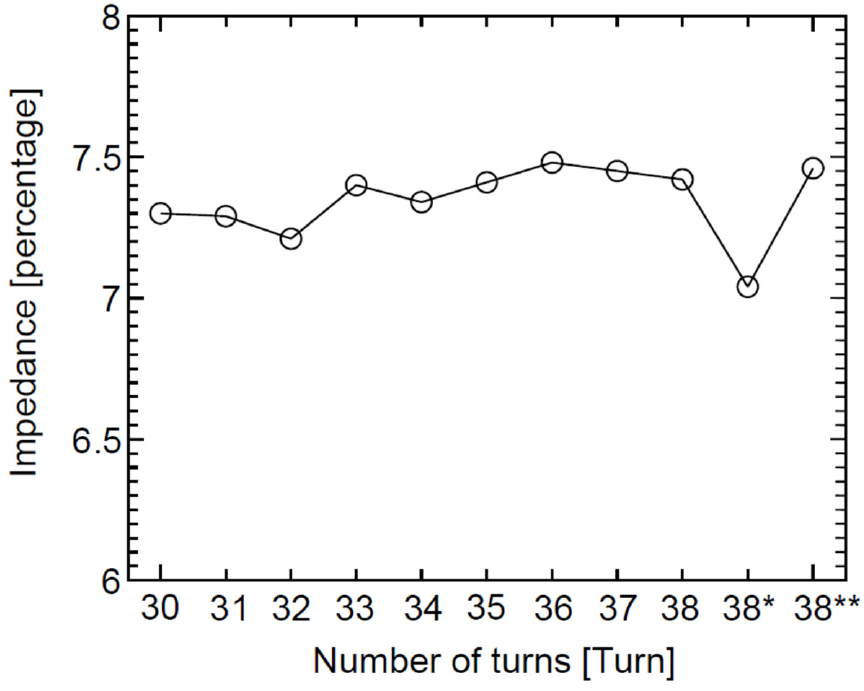
Figure 7. The total loss when the secondary winding changes.